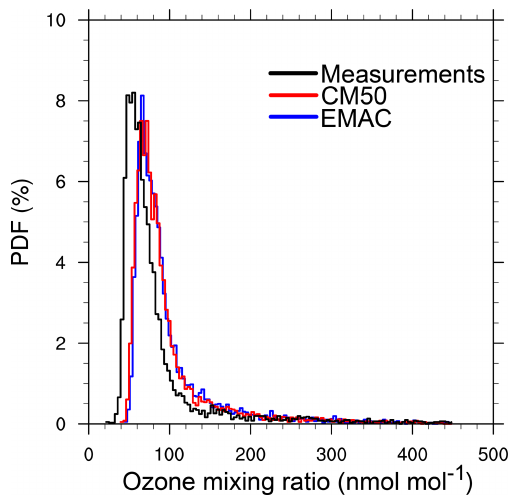
Figure 5. Probability density functions (PDFs) of observed (ozone sondes) and simulated vertical ozone mixing ratios in the pressure region between 600 and 200hPa. Considered are the 510 ozone sonde launches for 2008 in